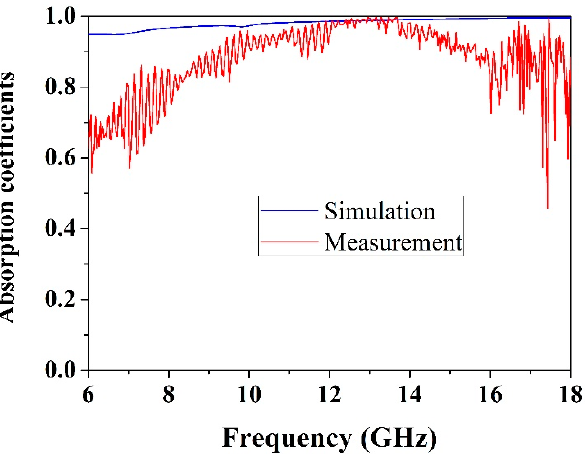
Figure 9. Simulated and measured absorption spectrum of the AgNWs-based transparent metamaterials microwave absorber (TMMA).